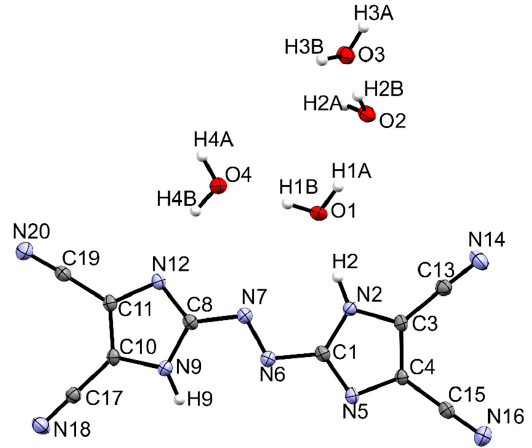
Figure 3. Crystal structure of TCAD · 4H 2 O. Ellipsoids are scaled at 50% probability. Table 1. Crystal data and structure refinement for TCAD · 4H 2